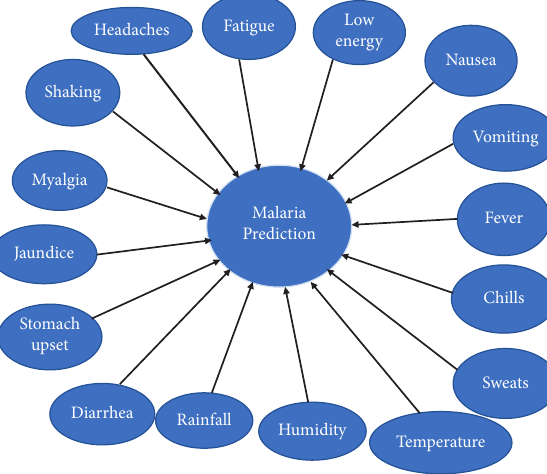
Figure 5: Proposed trained BN model. Figure 4: Proposed BN